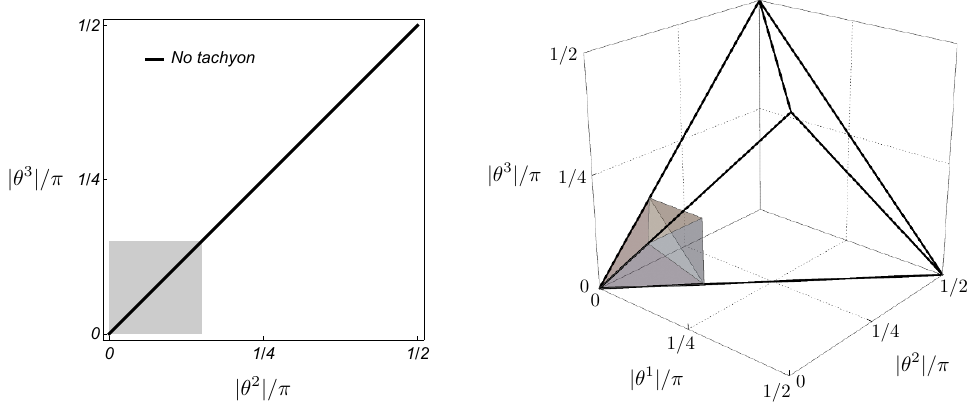
Figure 2 . Domain of angles for which no tachyons appear. Left: line in (cid:18) 2 no (cid:13)ux in (cid:12)rst torus, i.e. (cid:18) 1 = 0. Right: tetrahedron in case of (cid:13)uxes in all tori. The gray areas indicate small-angle domains with